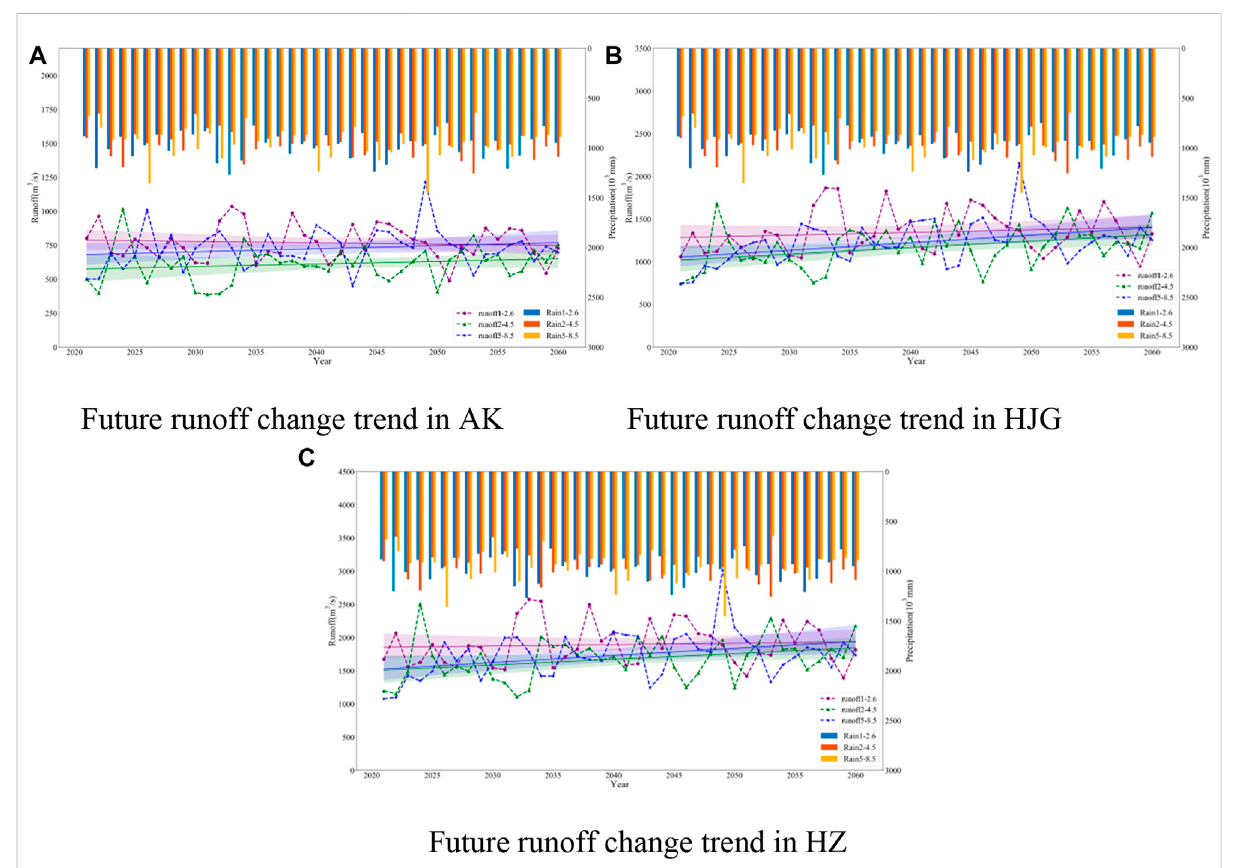
FIGURE 9 Overall changes of rainfall and runoff from 2021 to 2060 under different scenarios simulated by three typical sections. (A – C) are the overall inter-annual variation trend of runoff in AK, HJG and HZ under SSP1-2.6, SSP2-4.5 and SSP5-8.5